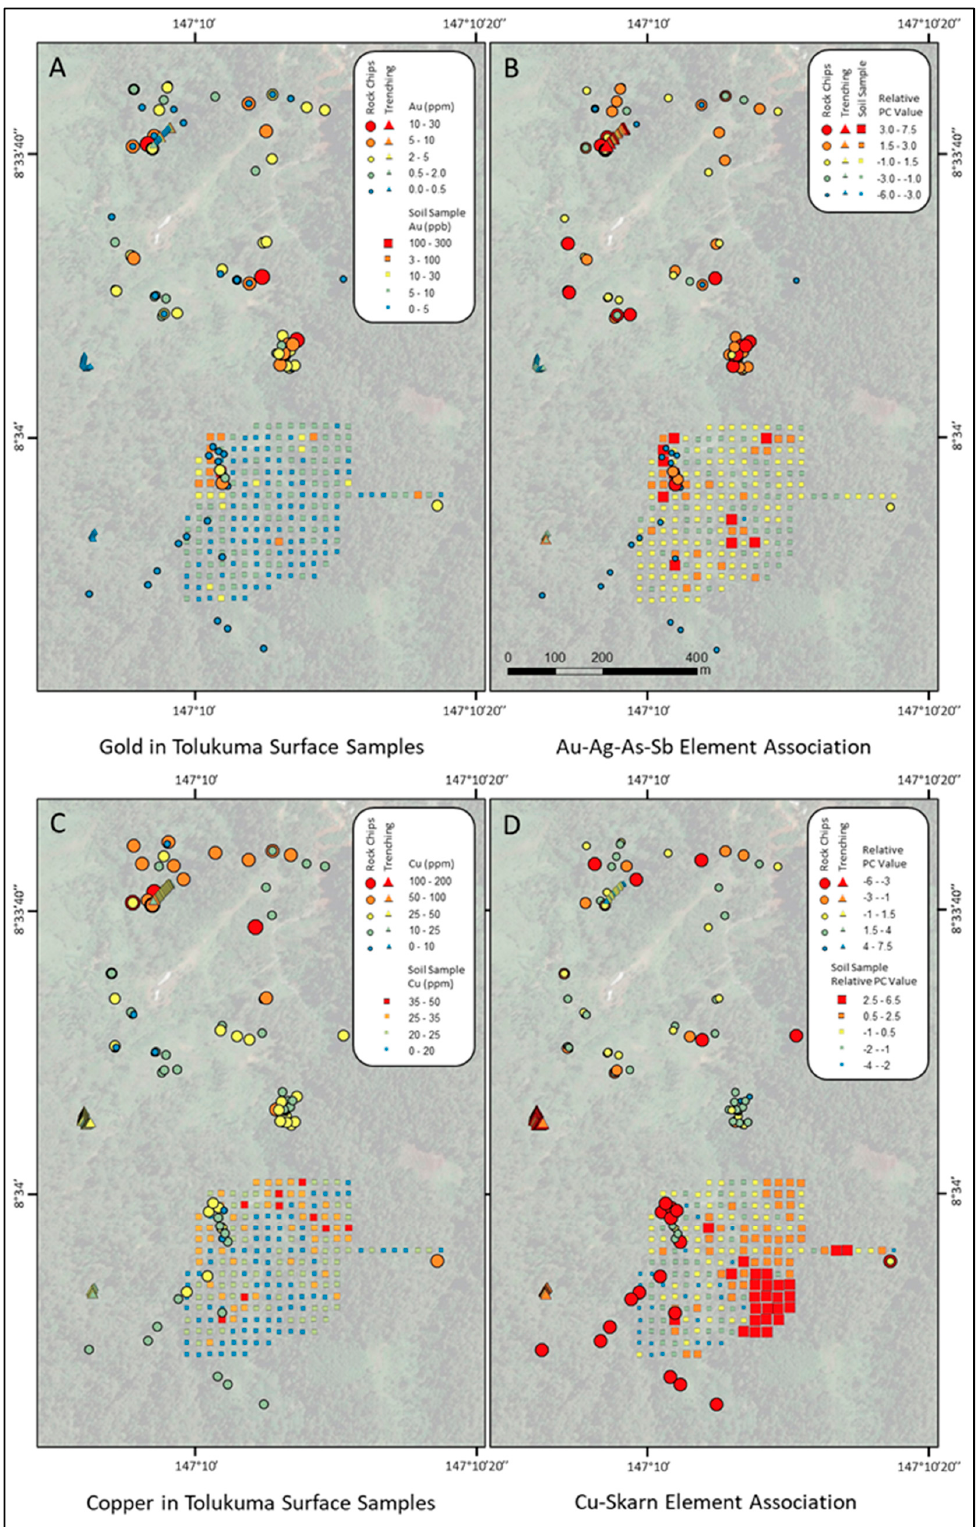
Figure 7. Tolukuma surface geochemistry and principal component analysis from trench sampling, rock chip sampling, and soil sampling: ( A ) gold in surface sampling; ( B ) Au − Ag − As − Sb element association from principal component analysis; ( C ) copper in surface sampling; ( D ) potential Cu–skarn element association; see text for discussion.